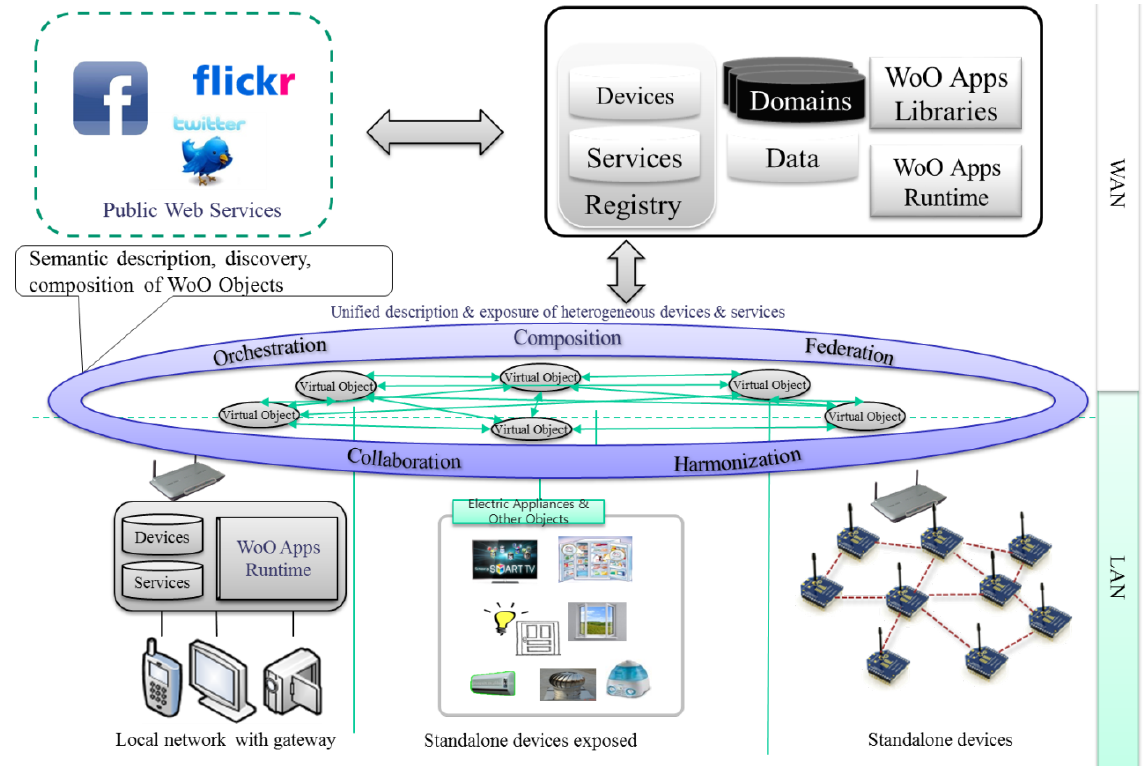
Figure 1. Context of Web of Objects (WoO). Physical objects in real world are represented as virtual objects, and virtual objects are utilized in collaboration, harmonization and composition with each other to form new application features to satisfy the service requirements initiated by users and